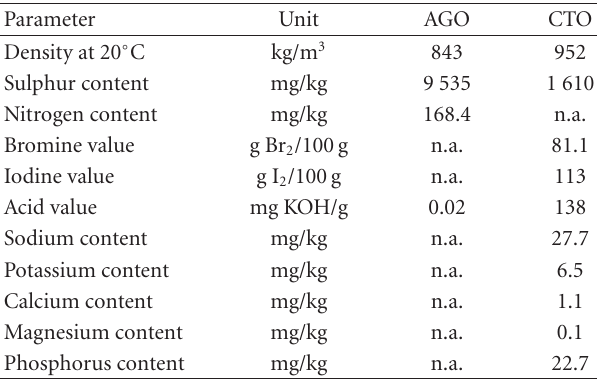
Table 1: Physical properties of straight-run atmospheric gas oil and crude tall